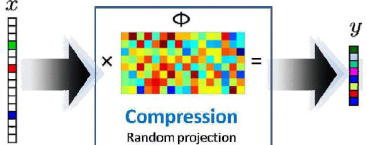
Figure 2. Sparse signal vector X can be sampled to be Y with much shorter for the compression